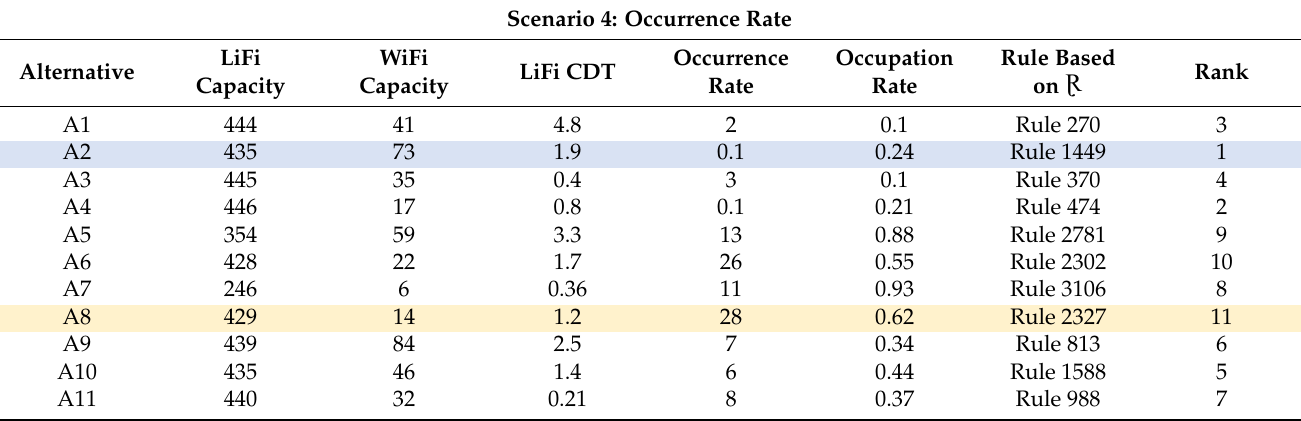
Table 12. Using Criteria #4 (occurrence rate) for ranking the best and worst alternatives.